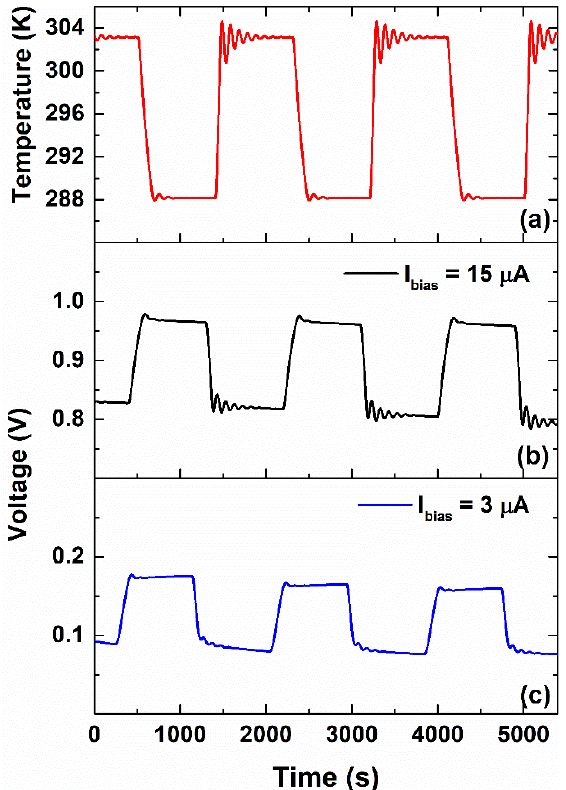
Figure 4. Time evolutions of the ( a ) square wave temperature profile imposed on the sample between 288 and 303 K and corresponding voltage signals, measured during the temperature stress, at bias current values of ( b ) 15 and ( c ) 3 µ A, respectively. The visible “ringing” effect is due to the operation of the PID system and is not significative for the understanding of the system